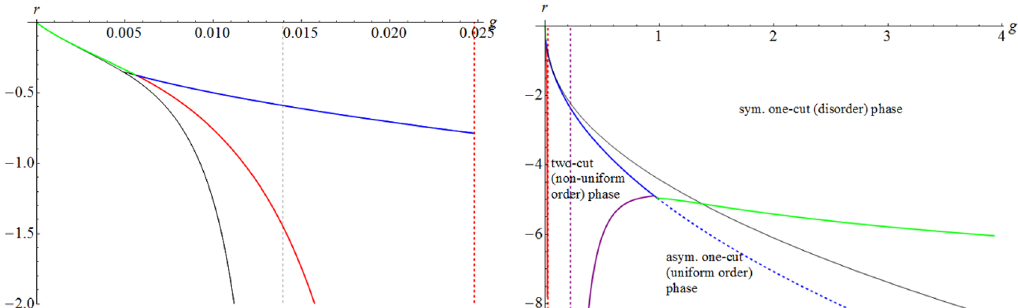
Figure 2 . Two views of the phase diagram of the model with the e(cid:11)ective action (4.15) for the value a = 3 e 3 = 2 (cid:25) 13 : 45. The left image compares the original phase diagram (shown in thin black line) to the modi(cid:12)ed transition lines. As before, the green line separates the symmetric one-cut solution from the asymmetric one-cut solution, the blue line separates the symmetric and one-cut and two-cut solutions and the red line separates the two-cut solution from the asymmetric one-cut solution. The right image shows the two new transition lines, purple between the two-cut and the new asymmetric one-cut solutions and green again between this new solution and the symmetric one- cut solution. In both images, the vertical dashed lines denote the asymptotes of the corresponding phase transition